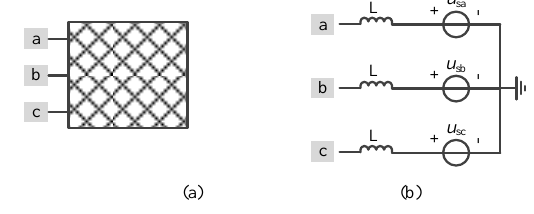
Figure 7. ( a ) AC grid; ( b ) Equivalent model of AC grid.